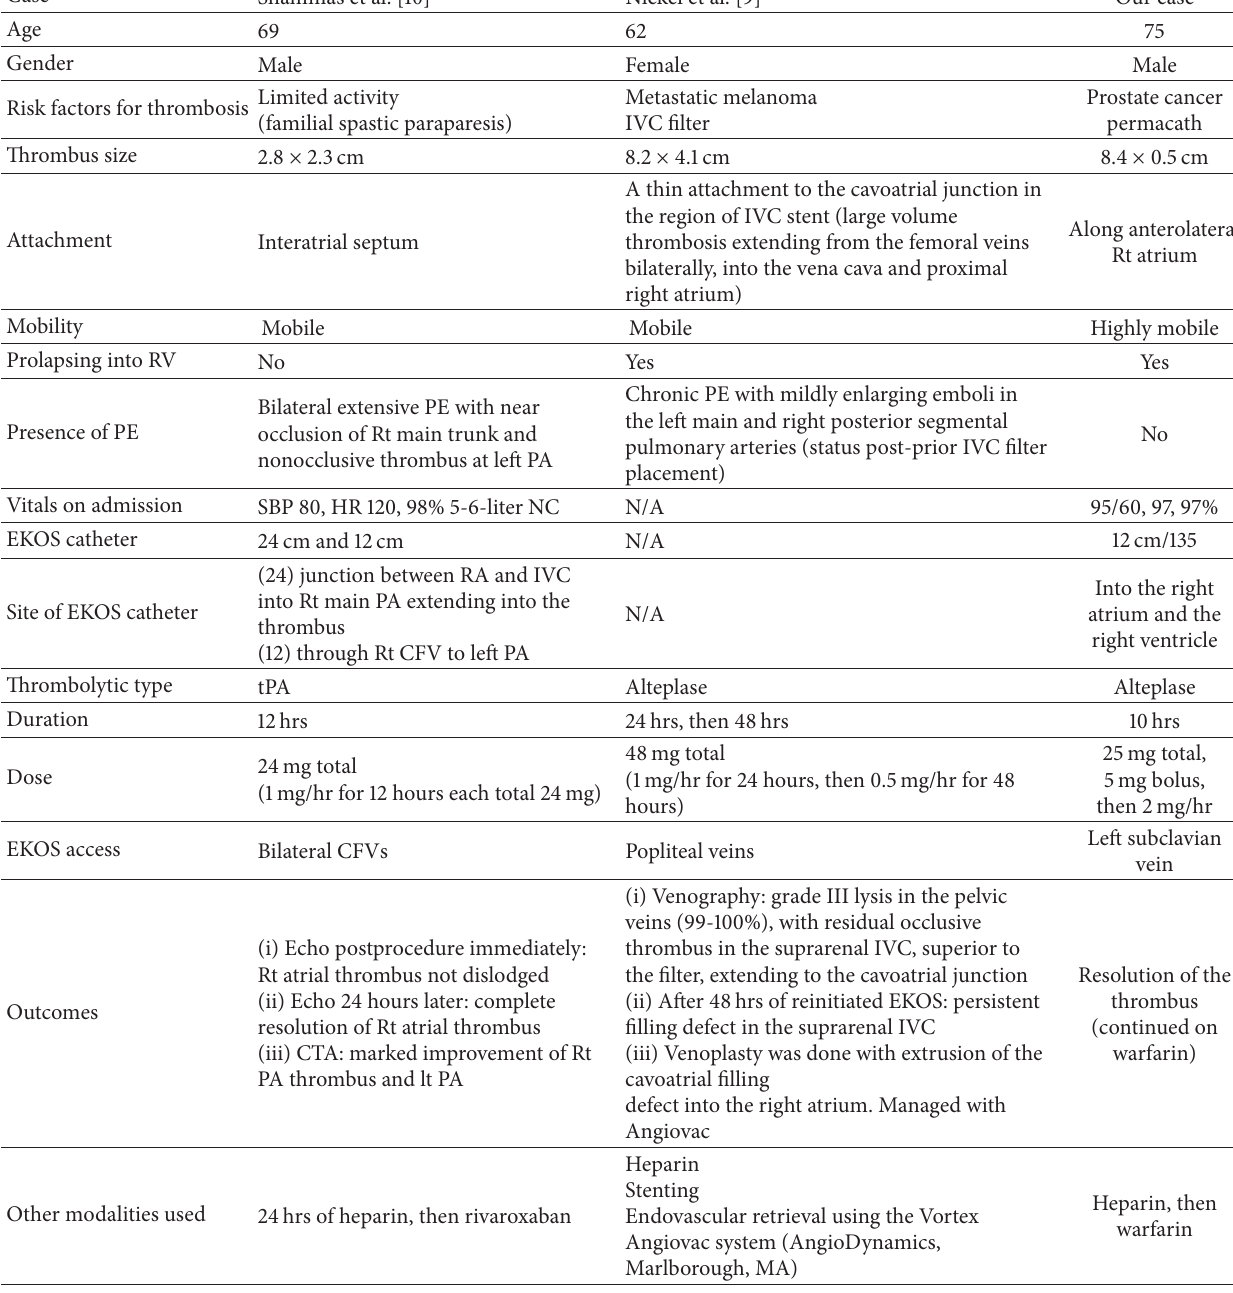
Table 1: Comparison between three cases where EKOS was used for treatment of a right atrial